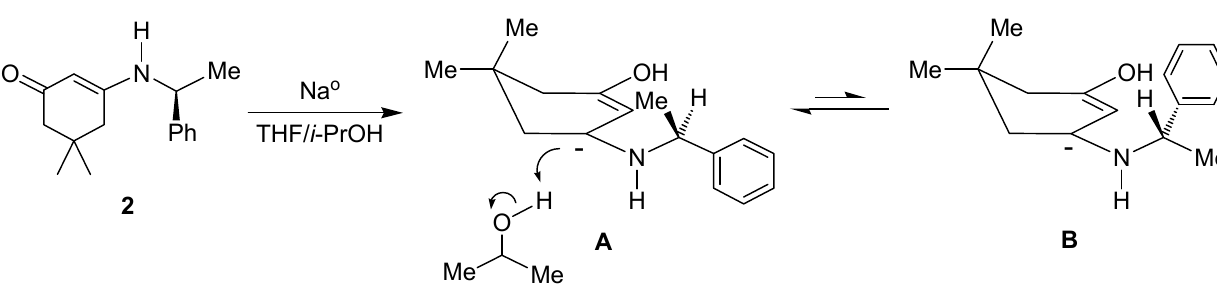
Figure 2. Plausible explanation of the diastereoselectivity in the reduction of 2